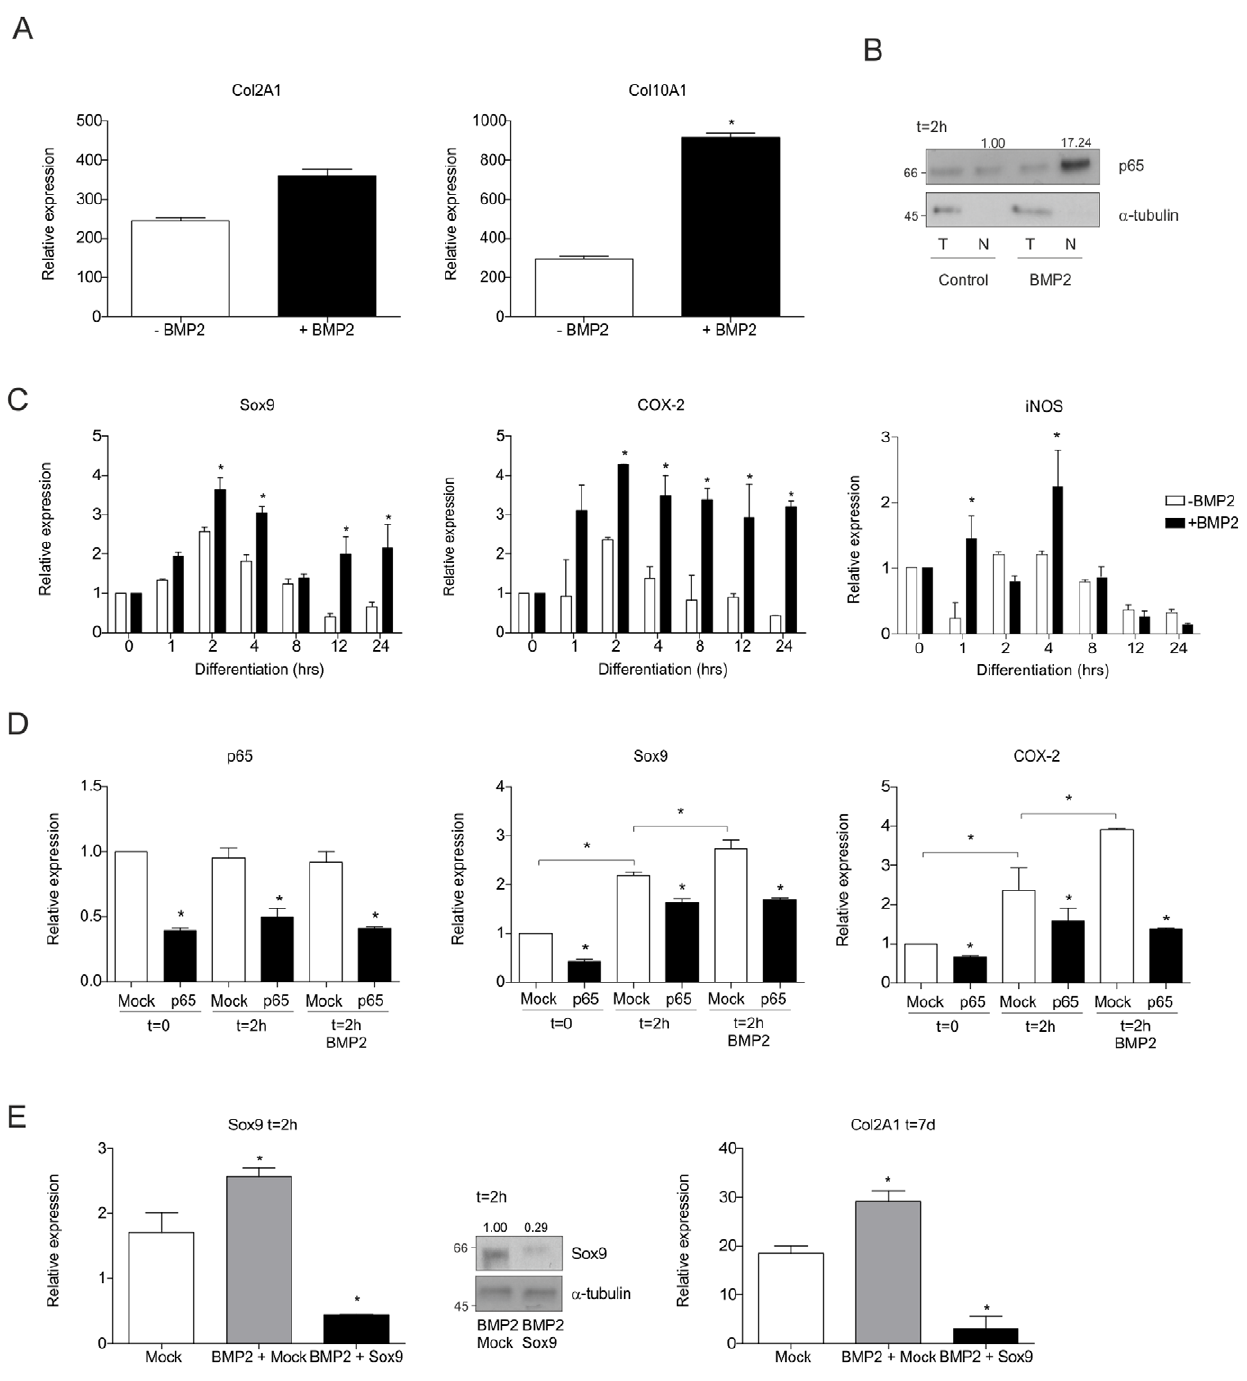
Figure 6. BMP2 activates NF- k B/p65 in early ATDC5 chondrogenic differentiation. A: ATDC5 was differentiated for 14 days in the absence or presence of BMP2 (30 ng/ml). Relative mRNA expression of Col2A1 and Col10A1 was determined. B: Cells were differentiated in the absence (control) or presence of BMP2 (30 ng/ml) and total (T) and nuclear (N) fractions were prepared at 2 hours in differentiation. NF- k B was detected as p65. C: Cells were differentiated for 0–24 hours in the absence or presence of BMP2 and expression of Sox9 (left) and NF- k B-targets COX-2 (middle) and iNOS (right) was determined. D: ATDC5 cells were transfected with a p65 siRNA duplex or Mock siRNA duplex and differentiated in the absence or presence of BMP2 for 2 hours. Knock-down of p65 mRNA was confirmed at 0 and 2 hours in differentiation (left). Middle and right graphs show Sox9 and COX-2 mRNA expression, respectively. E: Left panel set: Sox9 KD at mRNA and protein level at 2 hours in differentiation in cells transfected with scrambled (indicated as ‘‘Mock’’) siRNAs, scrambled siRNAs in the presence of BMP2, or Sox9 siRNAs (indicated as ‘‘Sox9’’) in the presence of BMP2. Transfection was done the day prior to differentiation and BMP2 treatment was for the first 24 hours only. Right panel: Col2A1 mRNA expression was determined in same experiment at day 7 in differentiation. *=p , 0.05.